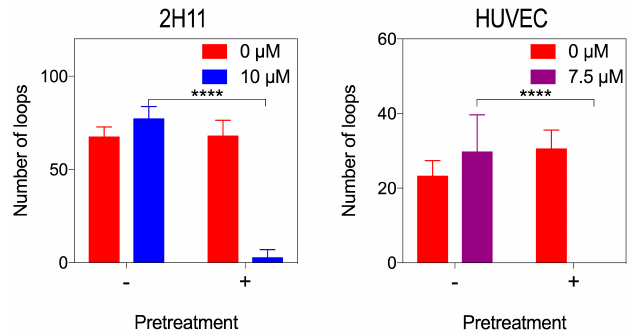
Figure 7. Lower concentrations of bacopaside II inhibited endothelial tube formation of 2H11 and HUVEC after pre-treatment with the drug. 2H11, and HUVEC were cultured in either normal medium or were pre-treated for 20 h with bacopaside II at 0 and 10 μ M for 2H11 or 7.5 μ M for HUVEC. Untreated and pre-treated cells, resuspended either in vehicle or bacopaside II, were used in the tube formation assay and the number of loops counted. Data are the mean ± SD from two independent experiments ( n = 6). Asterisks represent p -values for bacopaside treated cells without pre-treatment relative to with pre-treatment (**** p < 0.0001) (two-way ANOVA with the Bonferroni test).